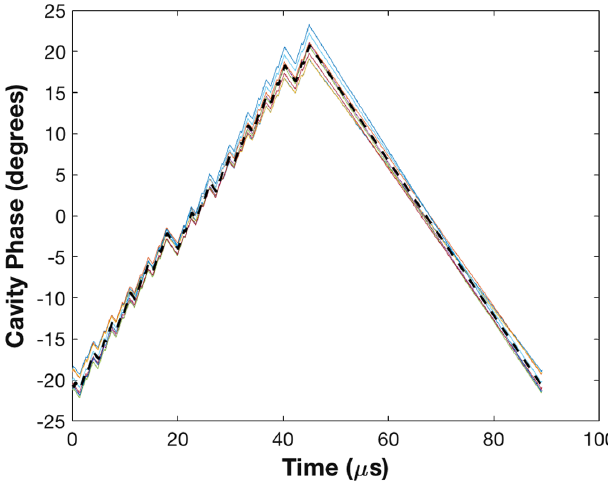
FIG. 15. Beam 2 bunch length and klystron 1B2 forward power. The yellow line indicates when the algorithm is on/off. The blue line shows the bunch length and the red line the klystron power.